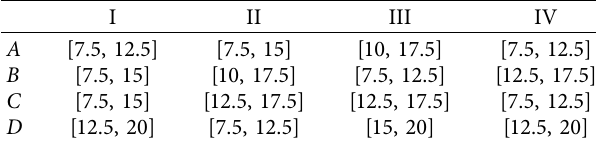
Table 8: Transformation of Table 6 at α � 0 . 5.